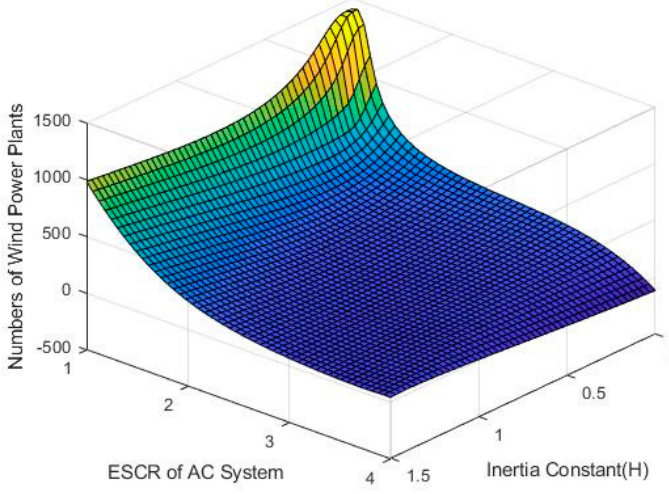
Figure 11. Relationship between inertia constant, ESCR of AC system, and number of offshore wind turbine deviations.